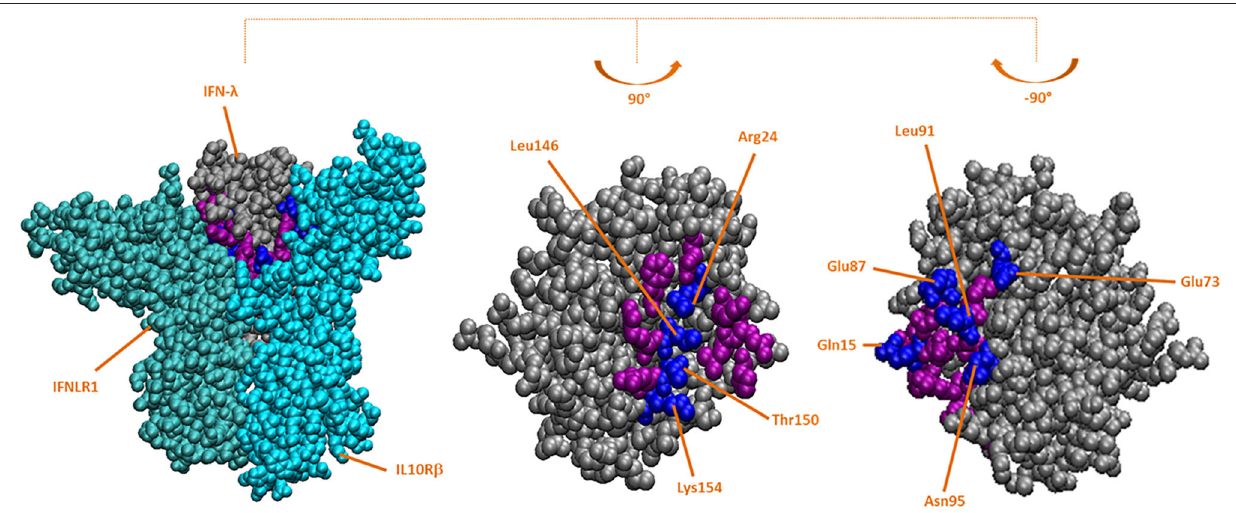
FIGURE 1 | Crystallographic structure of hIFN- λ and hIFN- λ /IFNLR in silico -mutated complex. Based on the crystallographic structure of the hIFN- λ 3/IFNLR complex (PDB: 5T5W), IFN- λ residues in the interface with IFNLR were replaced with those present in the bovine interface using FoldX software. All residues in the IFN- λ interface are colored purple and blue, and mutated residues (in blue) are indicated. Left: mutated structure of the hIFN- λ /IFNLR1/IL10R β complex; side faces of mutated hIFN- λ interacting with IFNLR1 (center) and IL10R β (right).